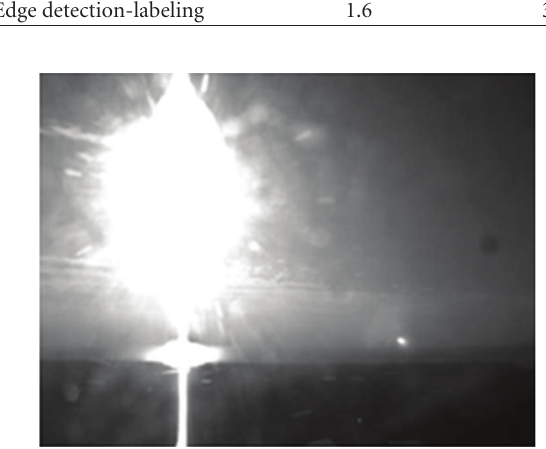
Figure 9: Sun presence detected by “Sun Detector.”